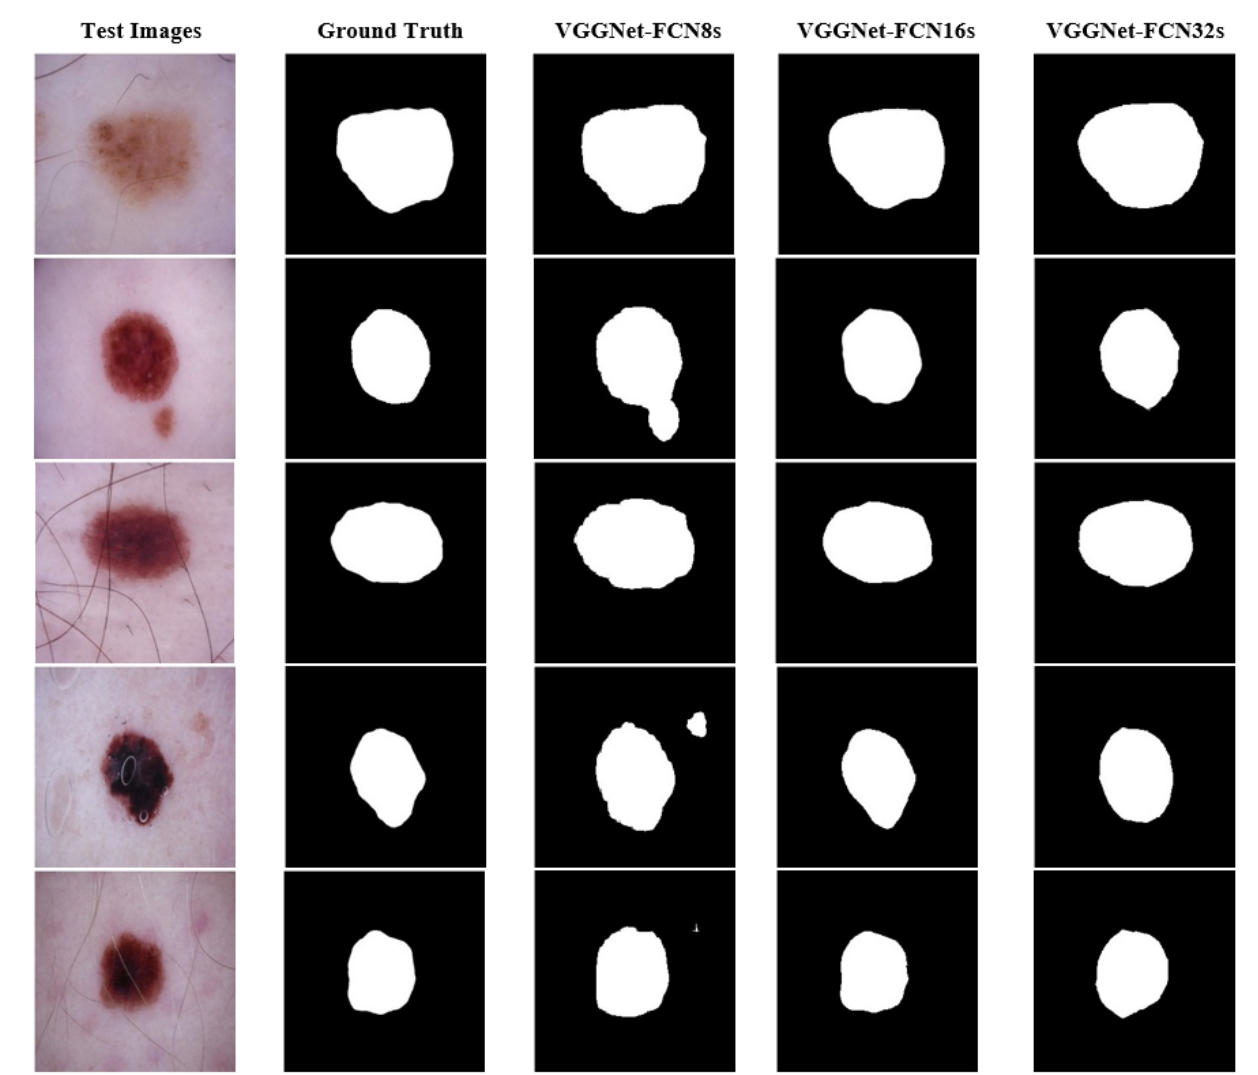
Figure 7. The visual estimation results based on sample dermoscopy images.